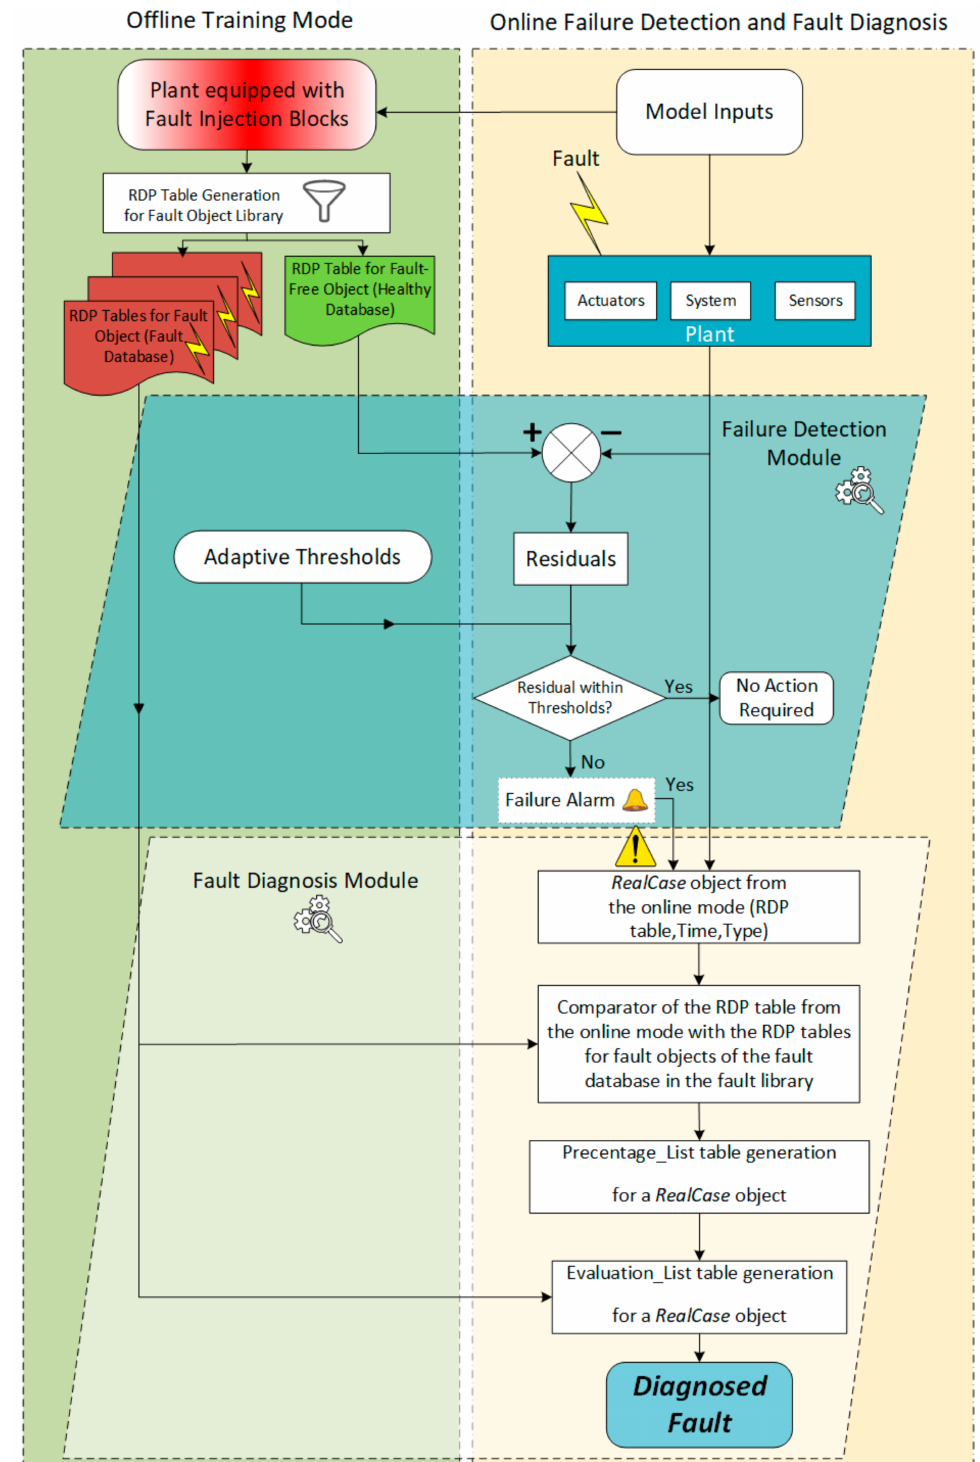
Figure 17. Overview of fault classifier in the